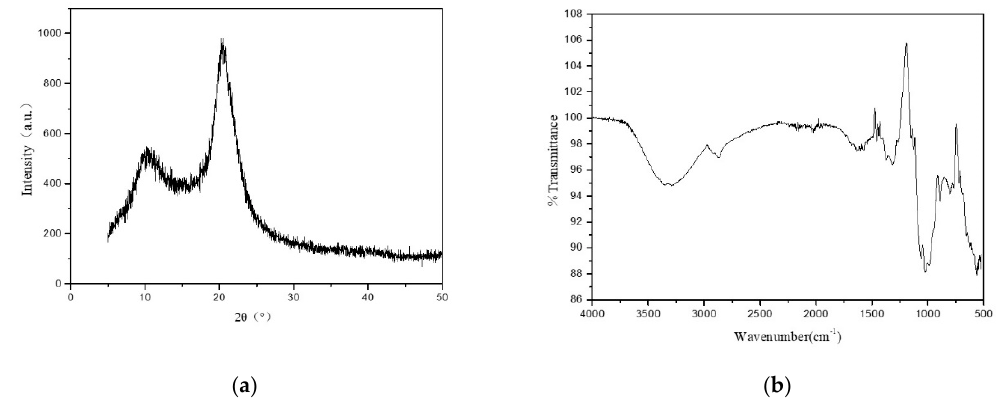
Figure 3. ( a ) XRD curve of chitosan fiber, and ( b ) infrared spectrum curve of chitosan fiber.